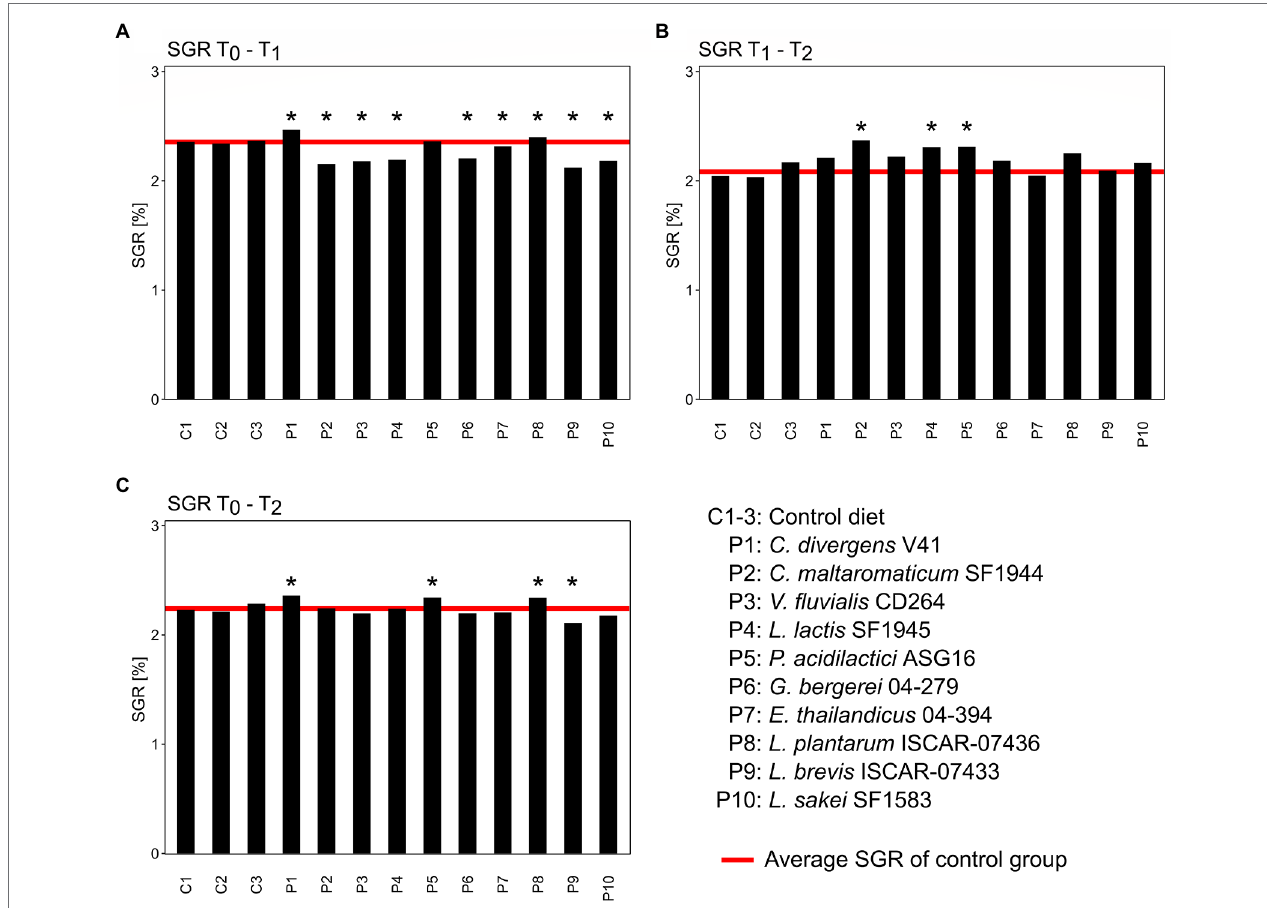
FIGURE 2 | Specific growth rates (SGR) of the different treatment groups (P1–P10) compared to the control (C1–C3) between the first 4-week growth period (A) , the second 4-week growth period (B) and the entire 8-week growth period (C) . Asterisks above bars indicate significant difference of the control groups to the treatment group based on one-sample t -tests ( p <